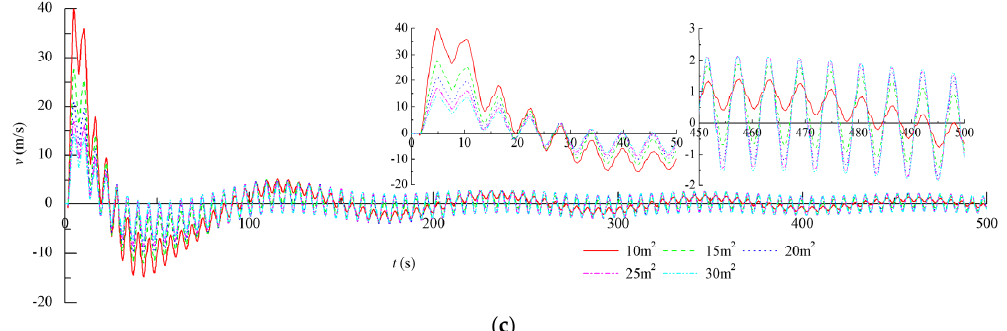
Figure 12. Effect of the ventilation tunnel sectional area on wind speed. ( a ) Positive and negative (extrema) envelope curves along the ventilation tunnel axis; ( b ) wind speed fluctuation processes in the first section; ( c ) wind speed fluctuation processes in the last section.